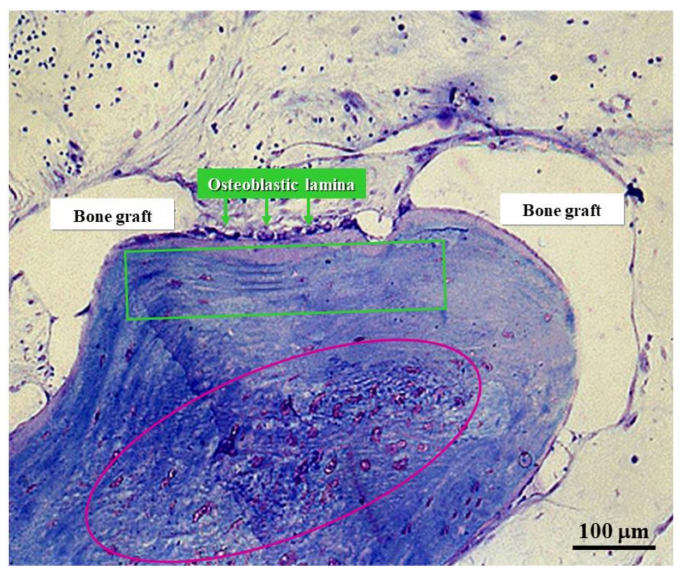
Figure 12. Micrograph under LM in ordinary light showing graft osseointegration. The purple circle outlines the core of a SO trabecula made up of woven bone containing many globous osteocytes. The green square outlines the lamellar bone subsequently laid down by